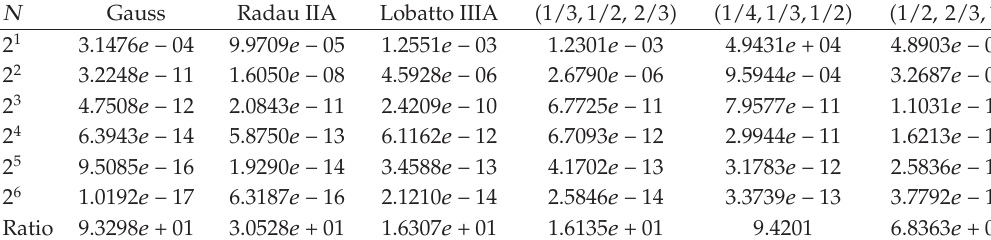
Table 2: The absolute values of absolute errors of u h for example (cid:2) 7.1 (cid:3) with m (cid:4)